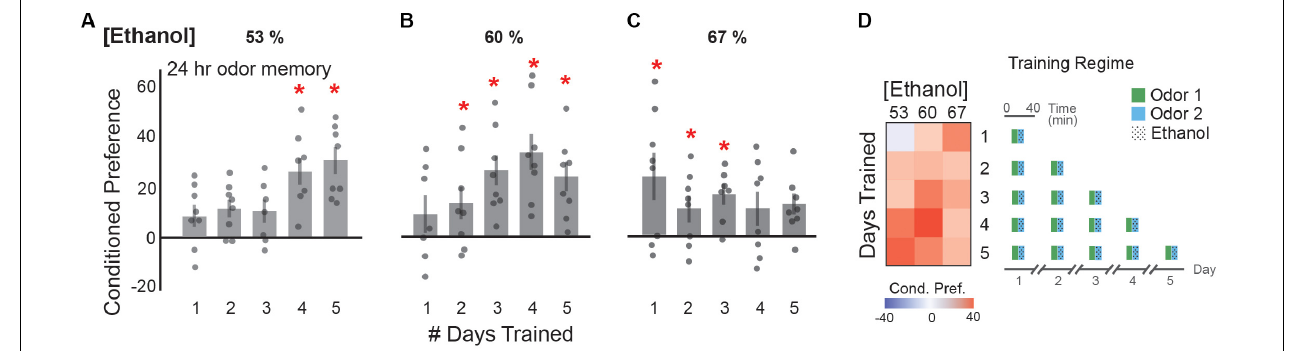
FIGURE 5 | Single daily exposures result in an appetitive ethanol preference. (A) Appetitive ethanol preference at 24 h increases with the number of single daily training exposures with a 53% ethanol concentration [4 trials t (11.66) = − 5.76, p = 0.0001; 5 trials t (13.01) = − 4.70, p = 0.0004]. (B) Similarly, the number of daily exposures correlates with the magnitude of appetitive ethanol preference observed at 24 h with a 60% ethanol concentration [2 trials t (13.83) = − 2.27, p = 0.04; 3 trials t (13.09) = − 4.36, p = 0.0007, 4 trials t (8.42) = − 5.36, p = 0.0006; 5 trials t (11.01) = − 4.07, p = 0.002]. (C) Daily sessions of 67% ethanol concentration suggest saturated appetitive ethanol preference with greater than three training days, [1 trial t (9.82) = − 2.95, p = 0.01; 2 trials t (10.33) = − 2.43, p = 0.03, 3 trials t (11.43) = − 4.27, p = 0.001]. (D) Heat map summaries suggest that the number of daily exposure trainings correlate with the observed appetitive preference at 24 h, with the strongest responses in the middle, characteristic of a U-shaped response. Schematic of the training regimes are depicted. Bars represent mean + / − standard error. N ∼ 8 per group where individual data points represent N = 1 ( ∼ 100 flies) CPI. ∗ p < 0.05.